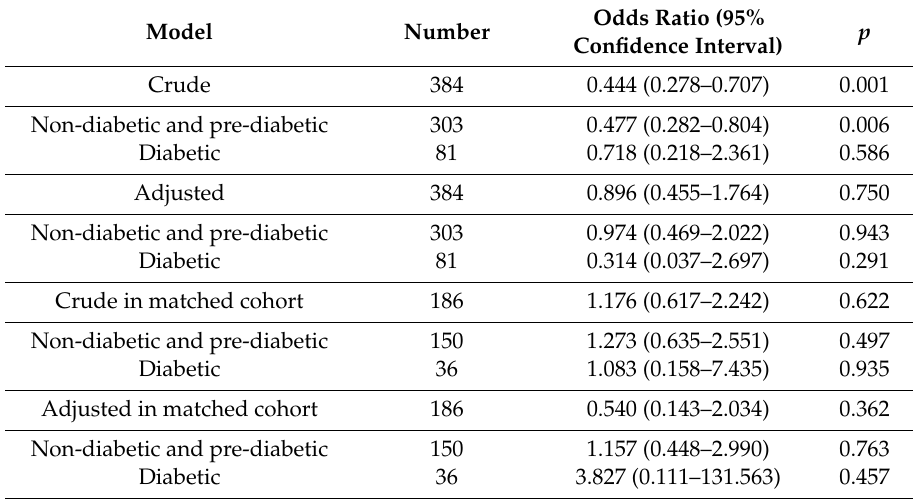
Figure 3. Outcomes according to estimated average glucose (EAG) or standard groups. ( A ) The EAG group had significantly lower unfavorable neurologic outcomes ( p = 0.001), lower serum neuron-specific enolase ( p = 0.001), and higher incidence of hypoglycemia ( p = 0.006) in the entire cohort. ( B ) The EAG group showed similar neurologic outcomes ( p = 0.728) to the standard group and had a neuron-specific enolase level ( p = 0.501) comparable to the standard group, and higher incidence of hypoglycemia ( p = 0.004). * Number of patients included in the analysis. Odds ratios of estimated average glucose versus standard group for unfavorable neurologic